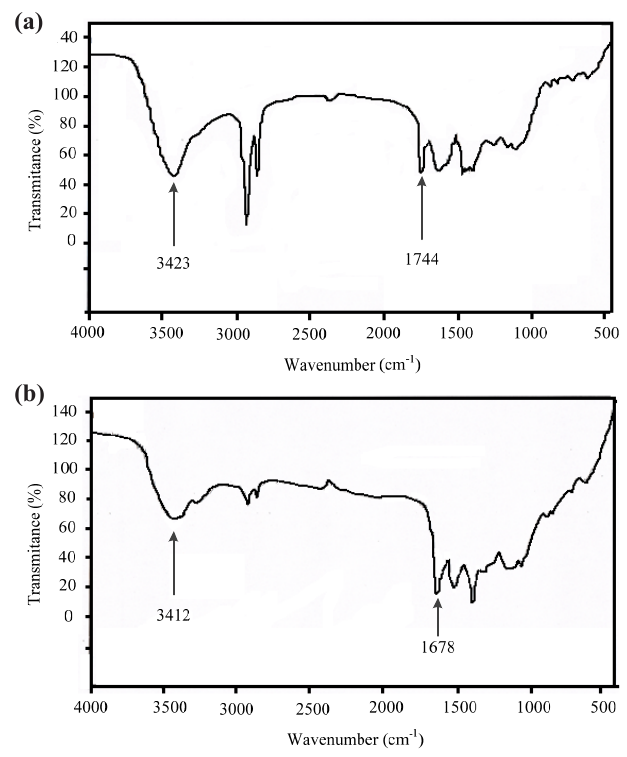
Fig. 3. X-ray diffractometer of the silver nanoparticles synthesized using L. officinale root aqueous extract.